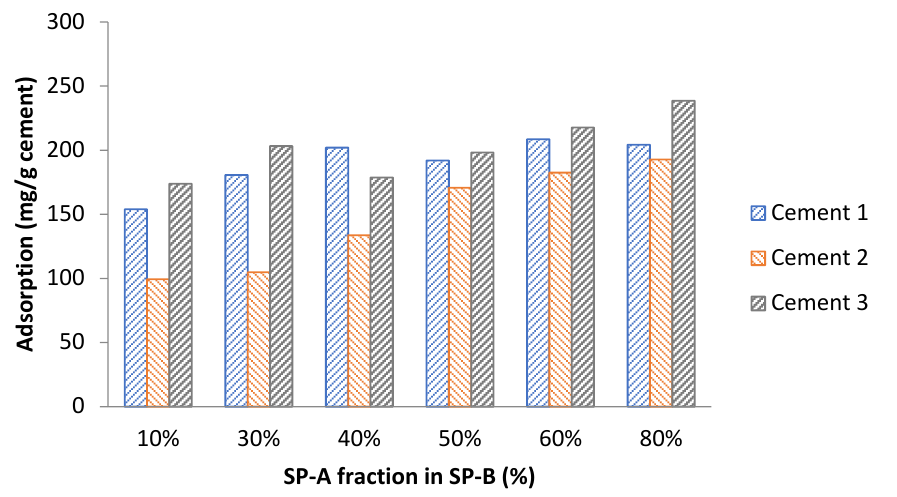
Figure 6. Summary of the adsorption (mg/g cement) of SP-C at 0.25% on Cement 1, Cement 2 and Cement 3.